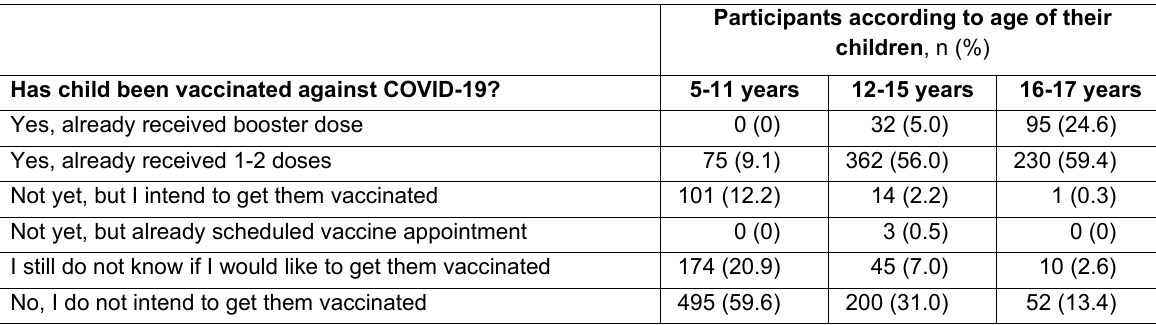
Supplementary table 7 . Parental intention to vaccinate their children and children's vaccination status